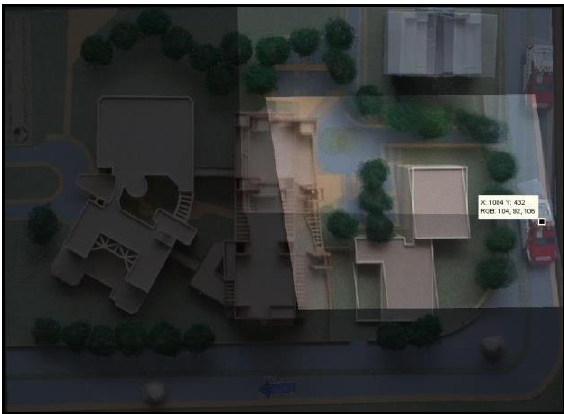
Figure 12. Geolocation of target in the second image frame.